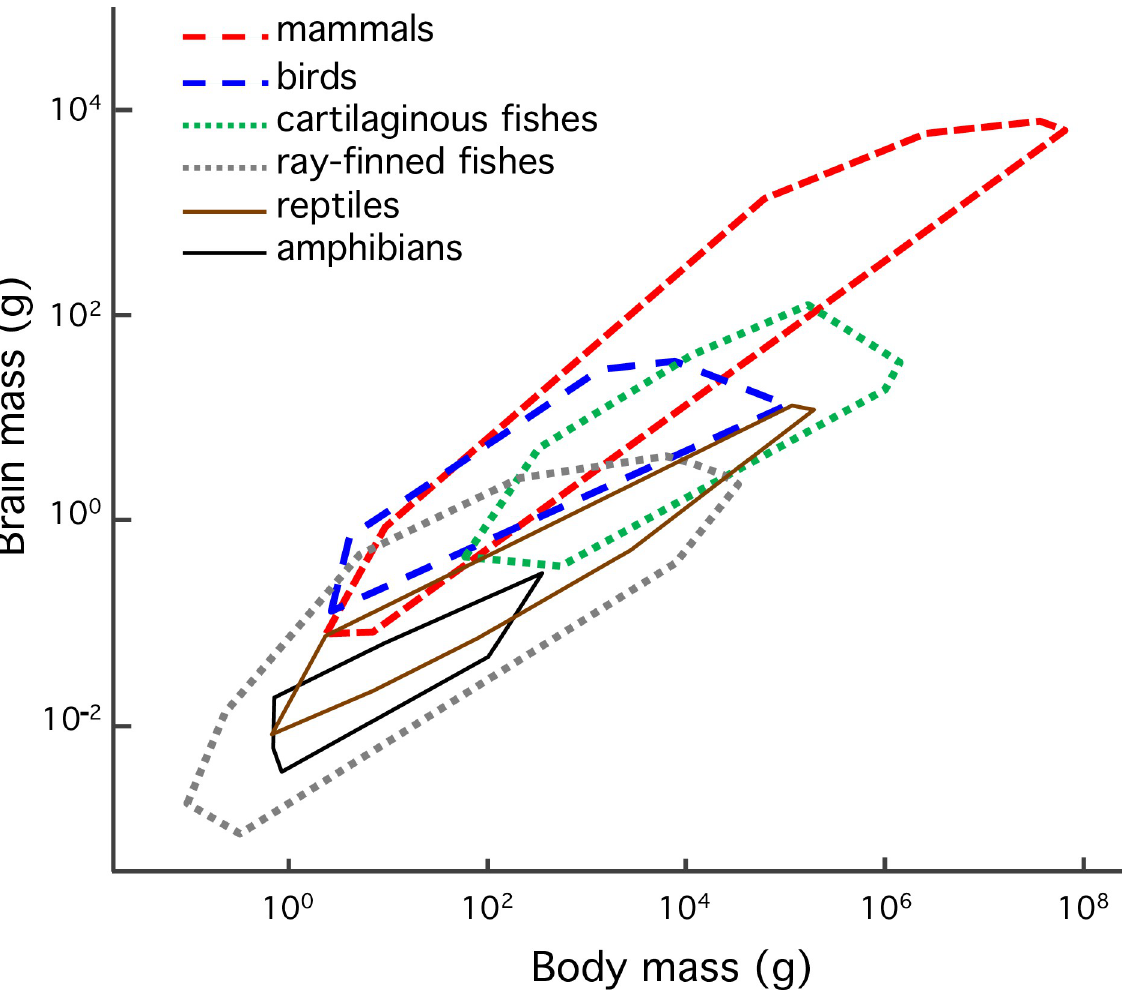
Fig 1. Brain size-body size envelopes of the major vertebrate lineages, to illustrate both intra-lineage and inter-lineage variation. The long-dashed outlines represent the 2 endothermic lineages (birds and mammals), the dotted outlines represent fishes, and the solid outlines the 2 ectothermic tetrapod lineages (amphibians and reptiles). Redrawn after